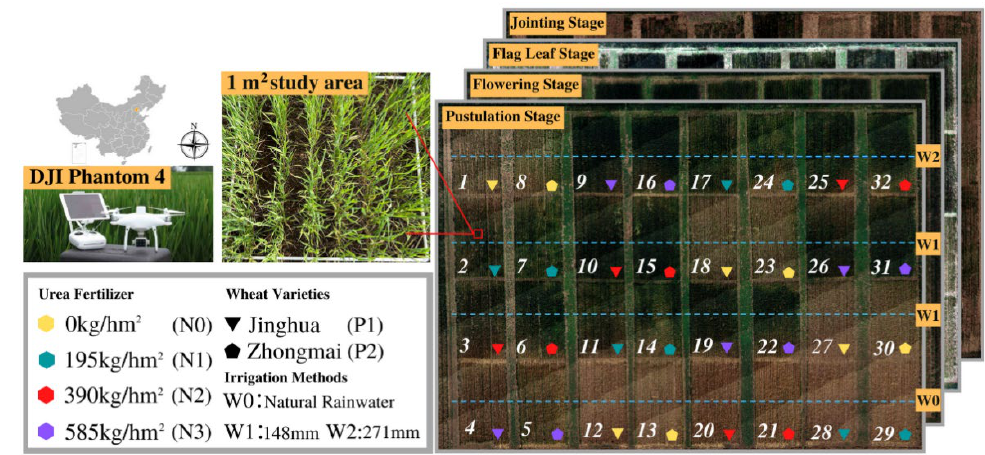
Figure 1. Diagram of the experimental site.